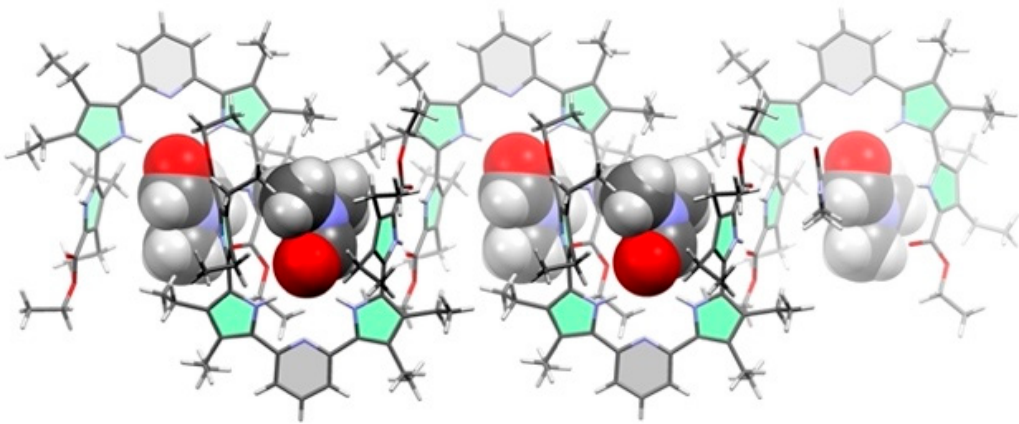
Figure 3. Polar-coordinating solvent-assisted host–guest complex of the hydrogen-bonded 1D supramolecular polymeric structure (DMF) n ⊂ ( 10 ) n grown from anhydrous DMF. DMF solvent molecules bonded with pyrrolic NH groups are denoted by the space-filling model for clarity.